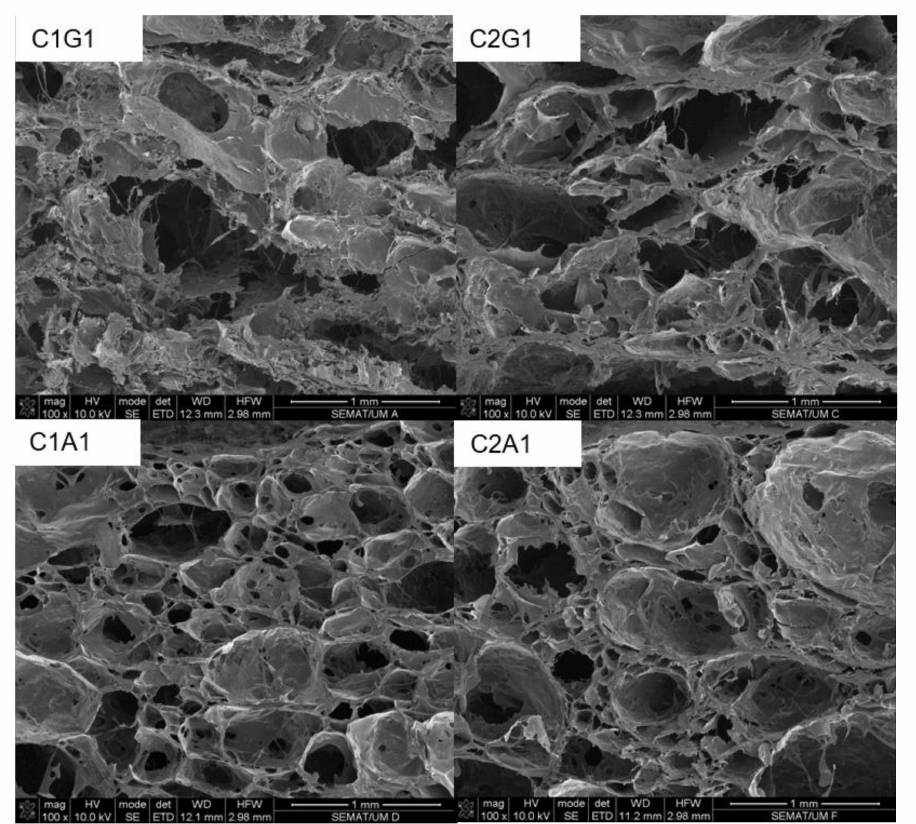
Figure 4. SEM images of superabsorbent hydrogels at di ff erent concentrations of biopolymers based on polyelectrolytes complexes. C1G1—Chitosan:Xanthan gum 1:1; C2G1—Chitosan:Xanthan gum